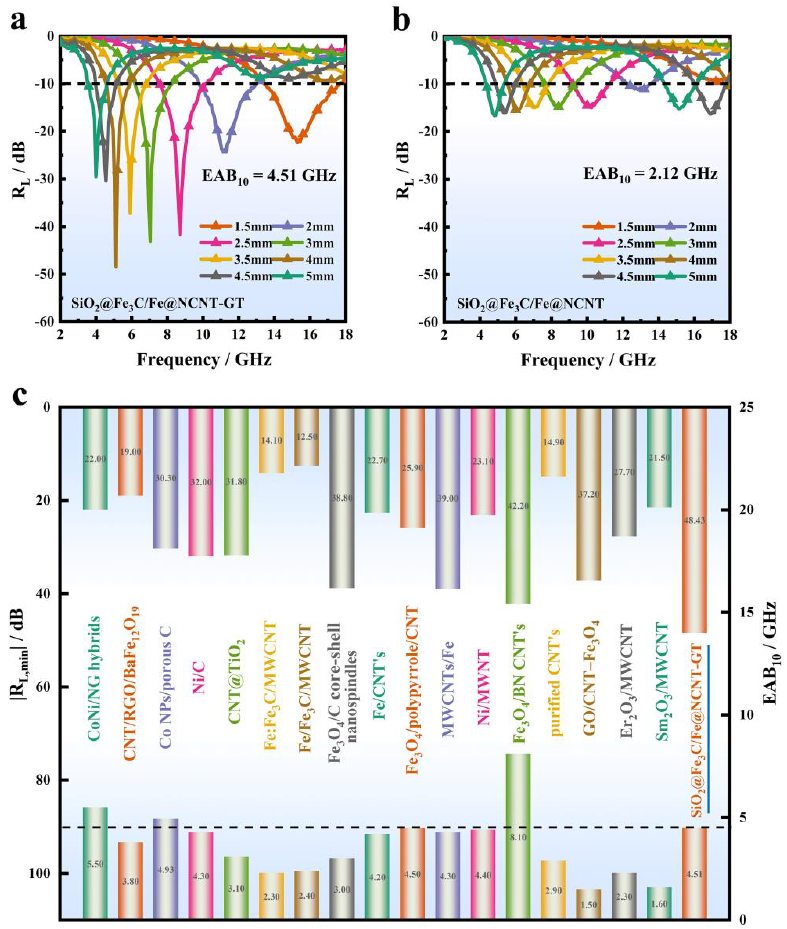
Figure 5. R L — f curves of ( a ) SiO 2 @Fe 3 C/Fe@NCNT-GT and ( b ) SiO 2 @Fe 3 C/Fe@NCNT, ( c ) the absorption performance of SiO 2 @Fe 3 C/Fe@NCNT-GT with previously reported absorbers.